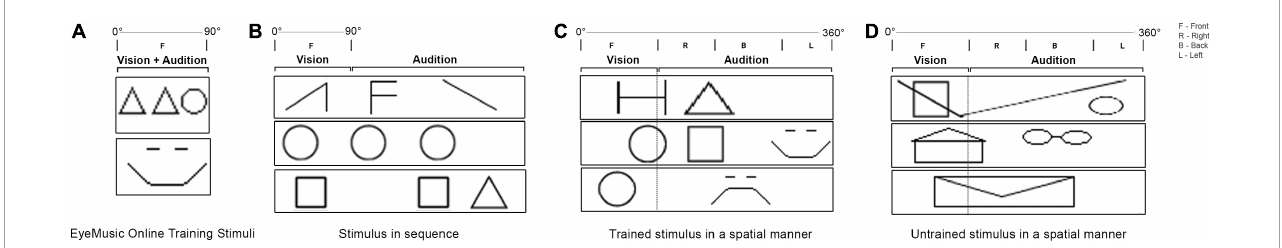
FIGURE2 Various types of stimuli used during the experiment. (A) Images used during the online training. Participants see the visual image and simultaneously hear the monophonic audio rendition that represents this image. (B) Stimulus in sequence, participants perceived in their front 90 ◦ a visual shape and afterward heard the rest of the auditory stimulus in headphones. (C) Stimuli with three shapes in sequence presented 360 ◦ around the participant. The front is visually projected, while the sides and back are rendered as spatial audio. (D) Unified audio-visual stimuli presented partially in visual and partially in